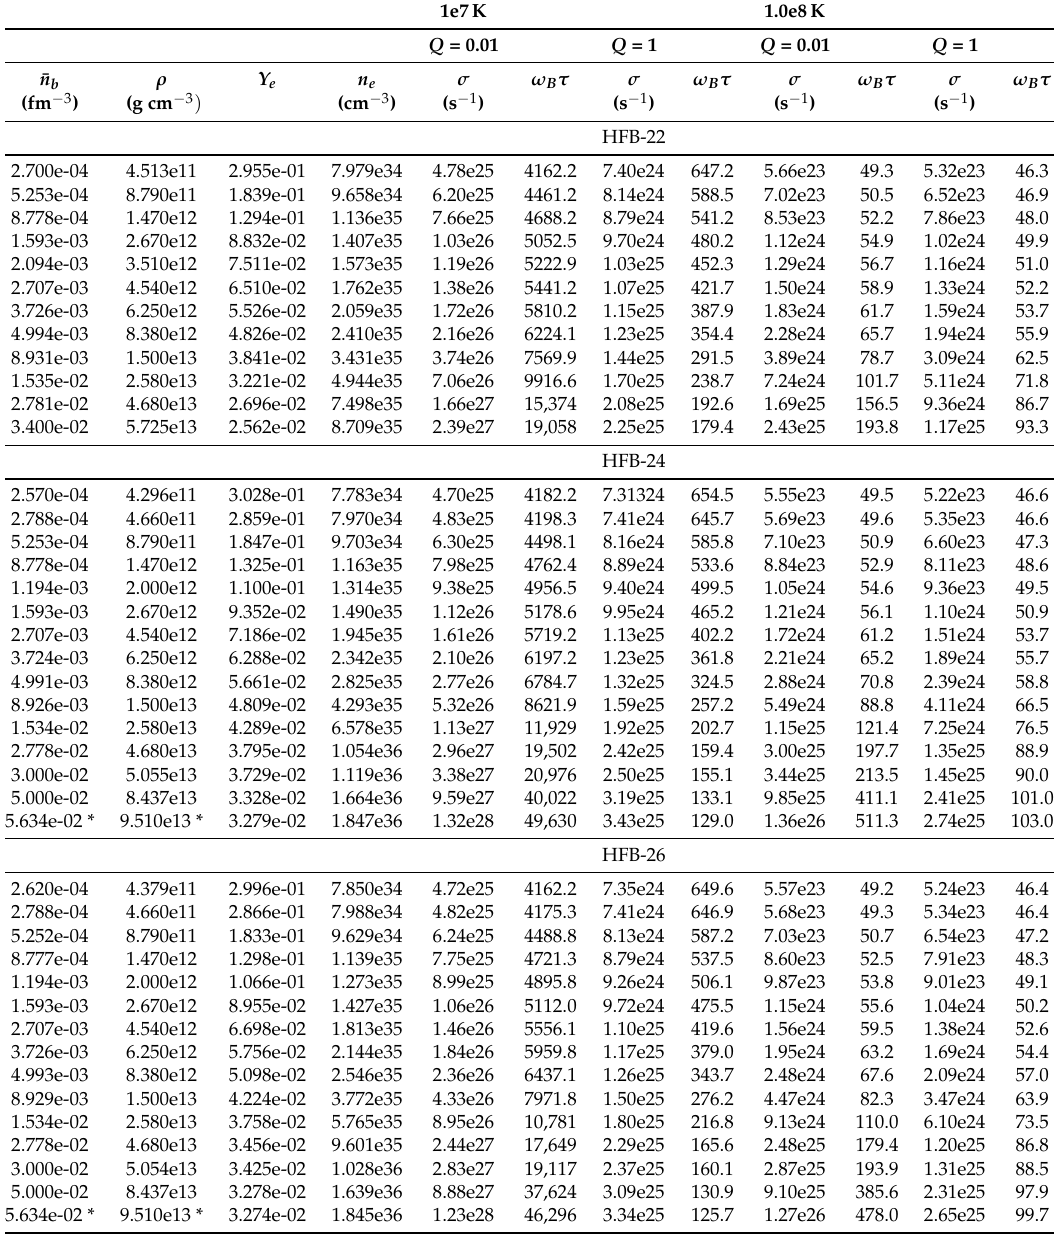
Table A2. Table 1 Partial values of electrical conductivity and magnetization parameter for two different temperatures T and two different impurity parameters Q in the inner crust of NSs for the nuclear mass models HFB-22, HFB-24 and HFB-26. The unit of magnetization parameter ω B τ is the normalized magnetic field B 14 when the dipolar magnetic field strength B = 1.0 × 10 14 G. Here the crust is assumed to be isothermal.